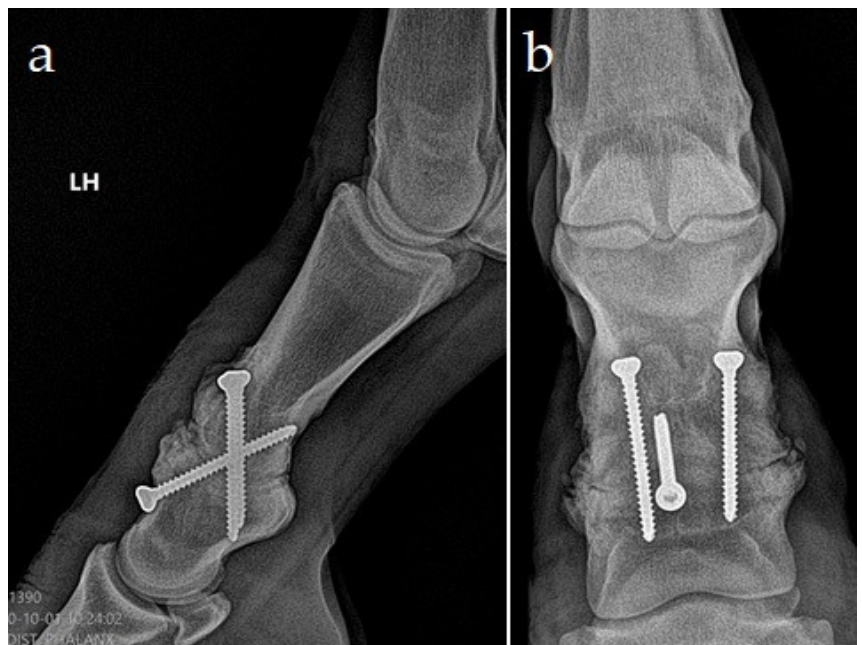
Figure 4. Lateromedial ( a ) and dorsoplantar ( b ) weight-bearing radiographs of the left hindlimb 3 months after surgery, demonstrating a nearly complete bony fusion of the proximal interphalangeal joint (PIPJ) and mild osseous dorsal, medial, and lateral periarticular reaction.